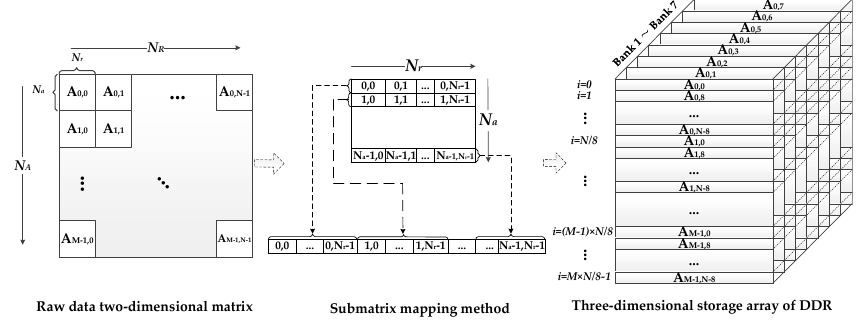
Figure 8. Submatrix three-dimensional mapping method.